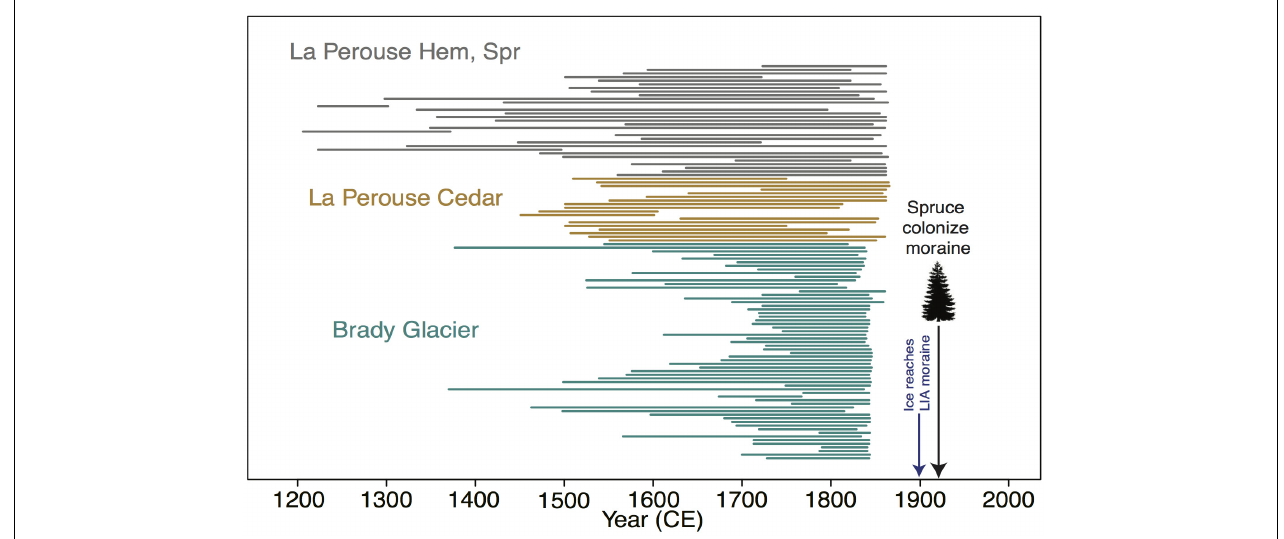
FIGURE 4 | Segment plot of crossdated tree-ring series from the exhumed forest at the La Perouse Glacier and from the nearby Brady Glacier ( Figure 1 ; Capps et al., 2011). The calendar ages of the outer rings correspond to the approach of the La Perouse Glacier and its ice-marginal outwash stream. The trees died after being buried by outwash gravel. Also noted are when the La Perouse Glacier reached its LIA moraine in 1895 as related to the Harriman Expedition by the US Fish Commission (Burroughs and Muir, 1986), and the earliest age of spruce that colonized that moraine indicating glacier